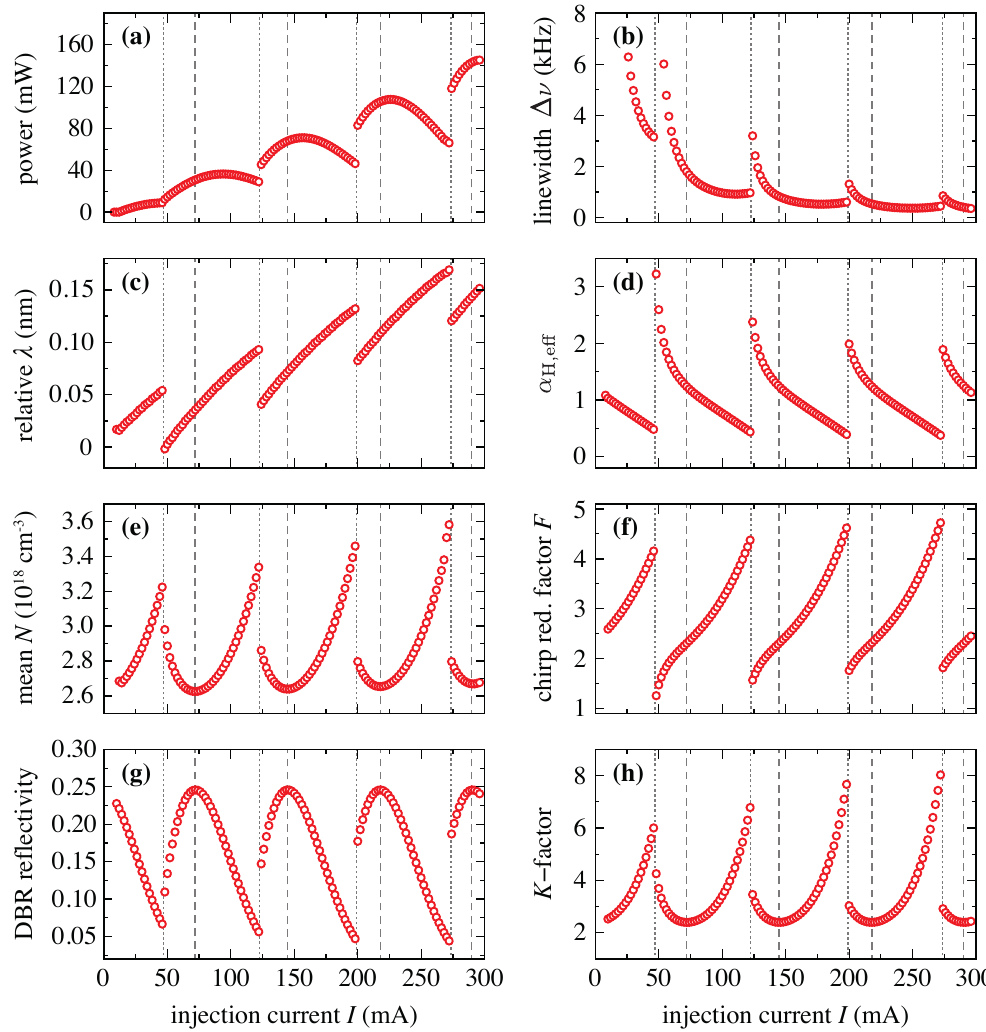
Figure 4. Simulated characteristics of the DBR laser as functions of the upsweeped injection current I . Dotted and dashed lines indicate mode jumps and maxima of the DBR reflectivity,